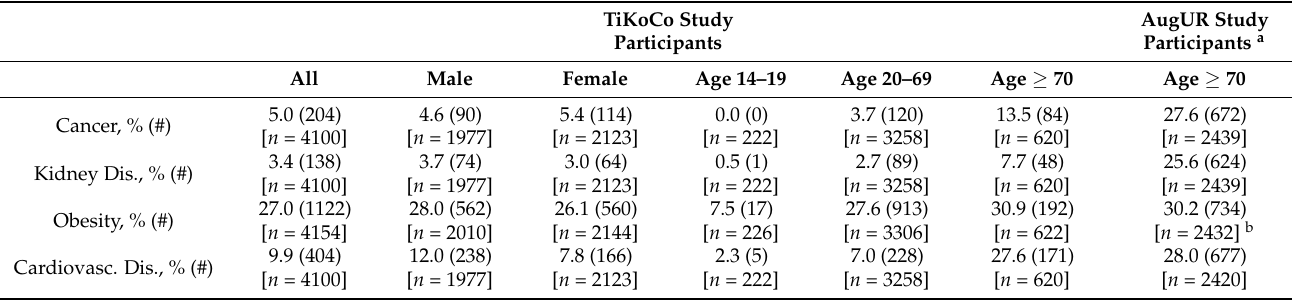
Table 3. Previous illnesses reported by participants. Participants were asked whether they ever had a physician diagnosing any of the following diseases, except for obesity, which was derived from self-reported height and weight. Relative (%) and absolute (#) frequencies based on information of [n] participants. Reports among individuals aged 70+ years (median age=77.0 years, 25th–75th percentile 72.0–81.0) were compared with AugUR study (median age = 78.9 years, 25th–75th percentile 75.7–82.5